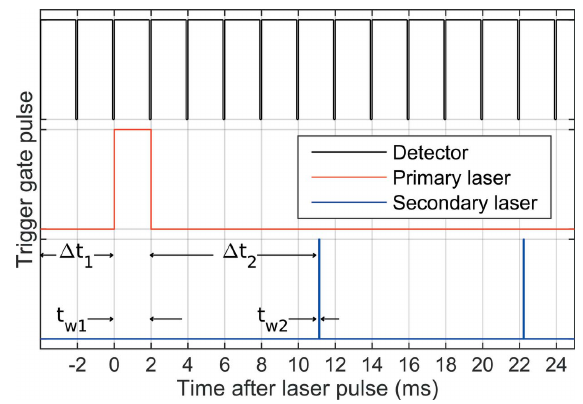
Figure 2 Trigger signals. When the trigger gate pulse is high, the detector acquires data or the laser fires. Trigger diagrams are vertically offset for